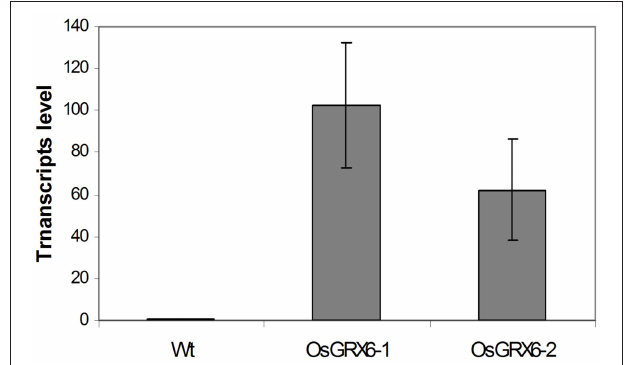
FIGURE 1 | OsGRX6 transcripts level in the leaves of 4 weeks old transgenic rice plants relative to wild type plants. Values are the mean of three biological and three technical replicates ( ±